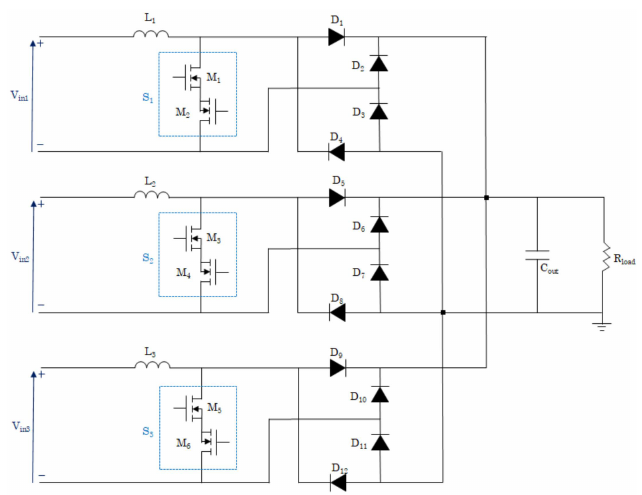
Figure 23. Secondary side diode three-phase circuit.